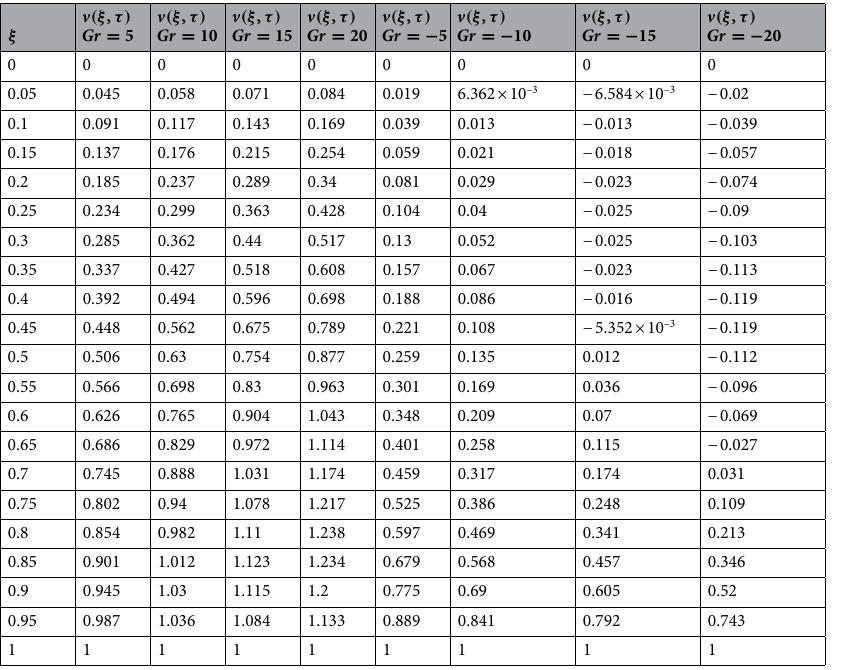
Table 3. The effects of Grashof number on the velocity profile of the